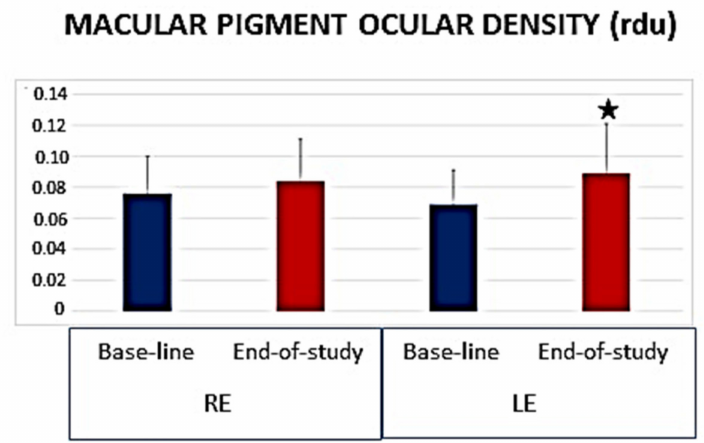
Figure 4. Parameters of the Macular Pigment Ocular Density. The volume is expressed in relative densitometry units (rdu). RE: right eye. LE: left eye.